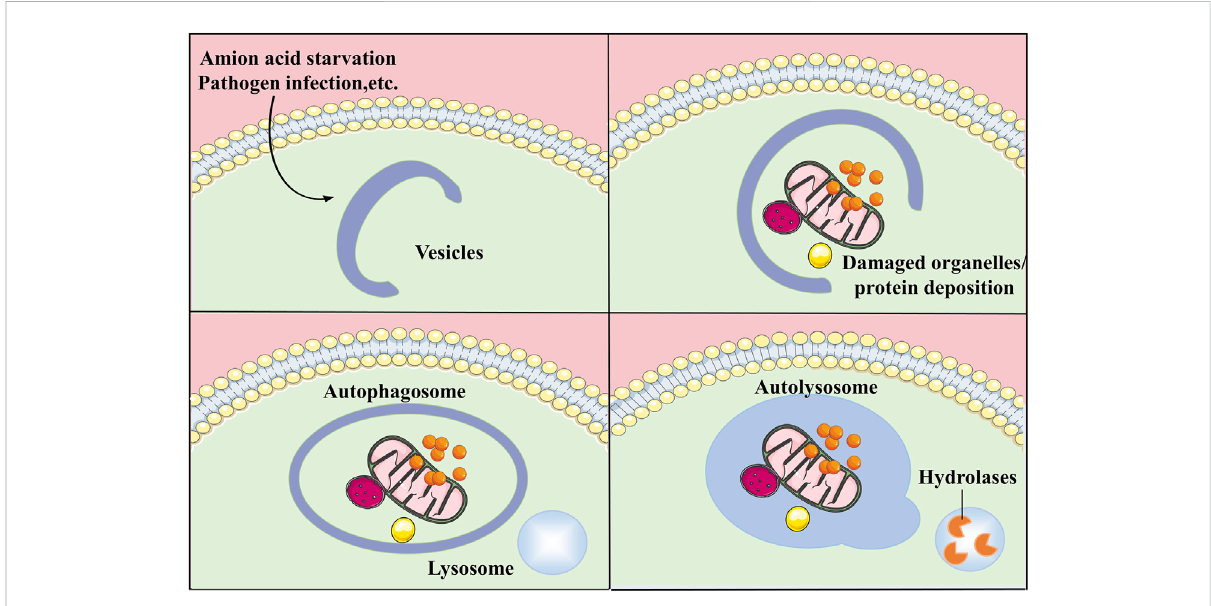
FIGURE 1 General process of autophagy. Autophagy is a process that engulfs its own cytoplasmic proteins or organelles and encapsulates them into vesiclesandfuseswithlysosomestoformautolysosomesthatdegradetheirencapsulatedcontents,realizingthecell ’ sownmetabolicneedsandthe renewal of certain